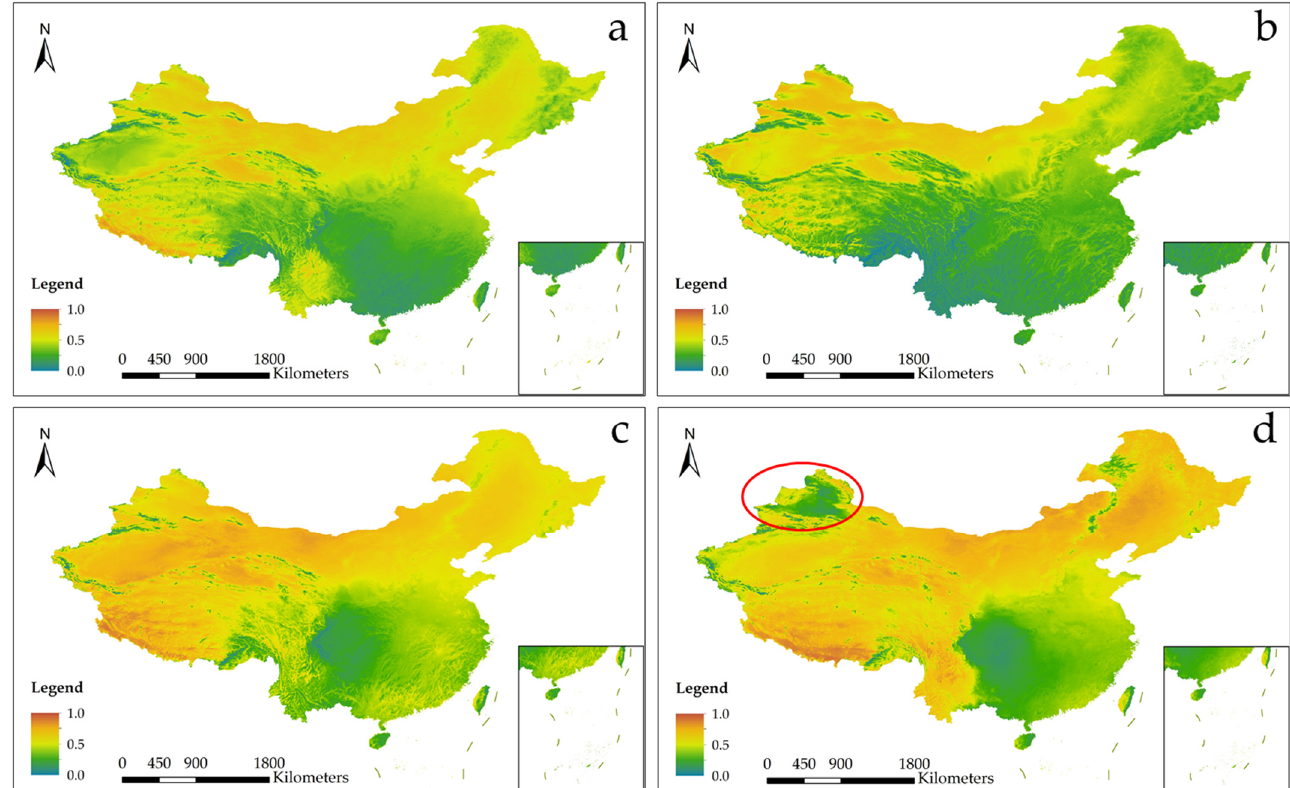
Figure 4. Sunshine percentage based on cloud cover in the spring ( a ), summer ( b ), autumn ( c ) and winter ( d ).